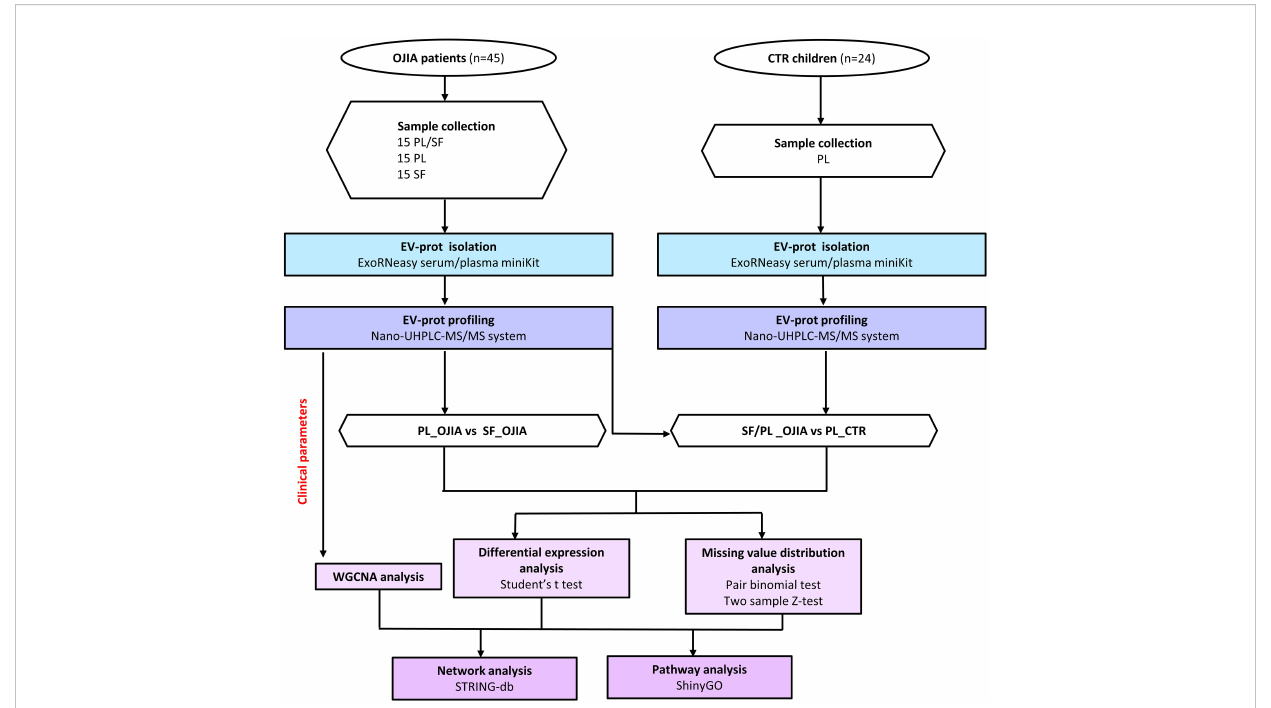
FIGURE 1 Flow chart of SF and PL sample processing and EV-prot isolation/analysis in OJIA patients and control children. SF and PL samples from forty- fi ve newly diagnosed OJIA patients with clinically active disease and PL from twenty-four control children were collected, and EVs were puri fi ed using the membrane af fi nity spin column, exoRNeasy Serum/Plasma kit. EVs were lysed with RIPA buffer, and EV lysates were processed according to the in-StageTip procedure. EV-prot expression pro fi le was analyzed by liquid chromatography-tandem mass spectrometry (LC-MS/MS).